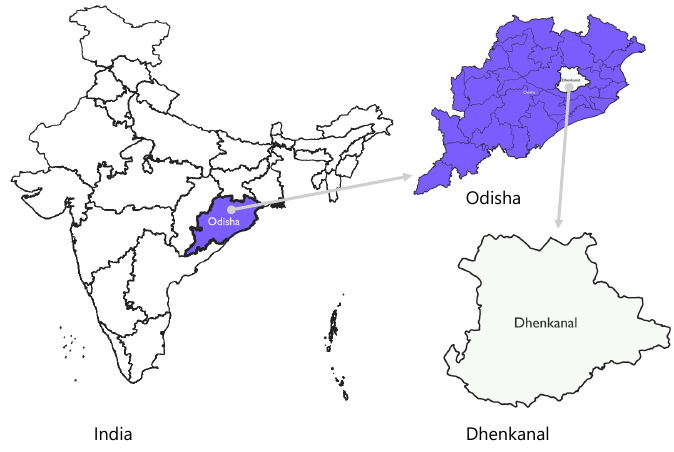
Figure 4. Site of